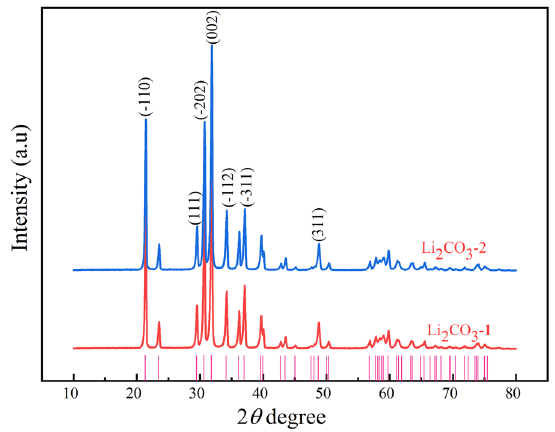
Figure 4: XRD diagrams of battery - grade Li 2 CO 3 products.